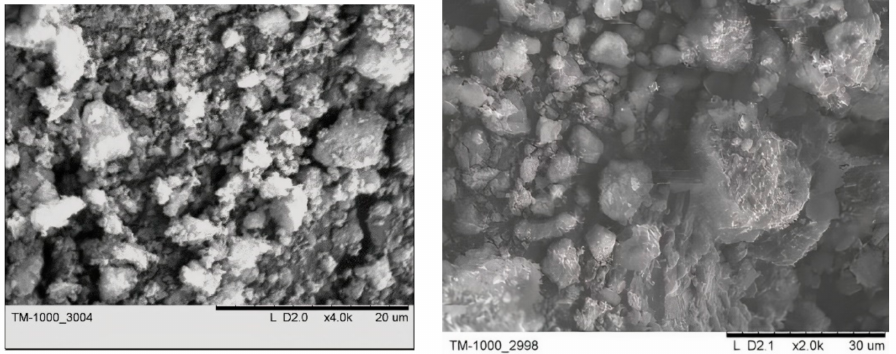
Figure 1. Typical SEM images of nanodiamonds.